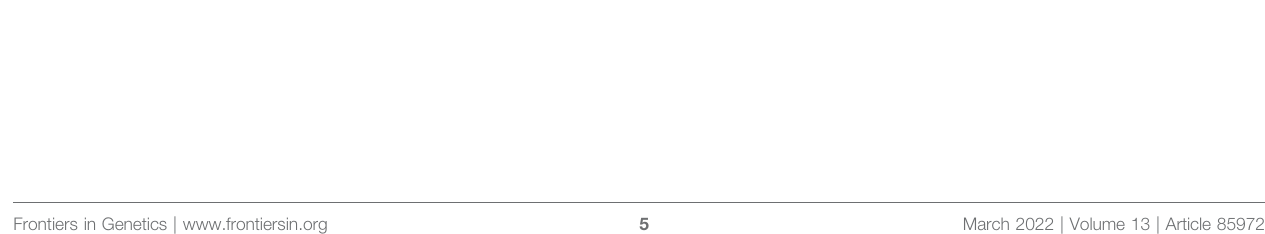
Frontiers in Genetics |